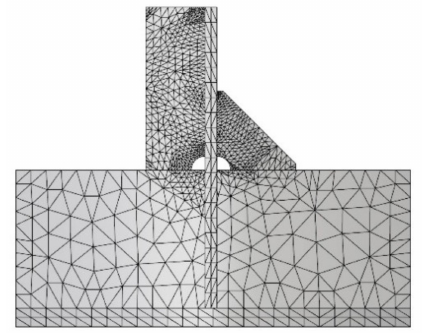
Figure 4. Meshing pattern Det3